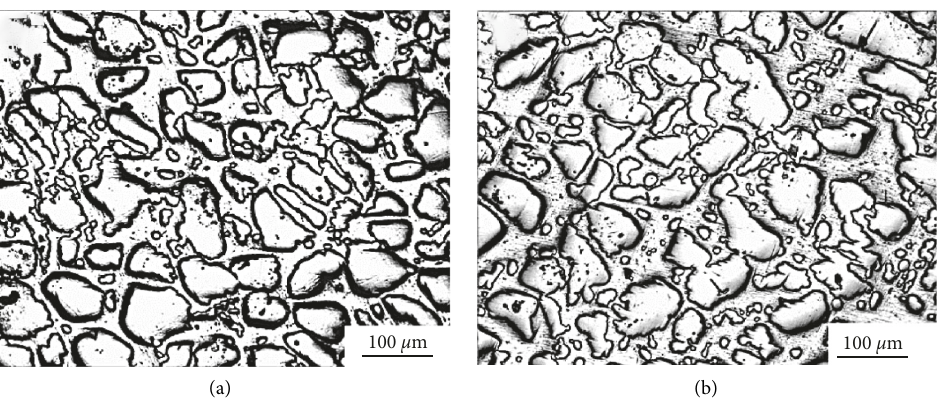
Figure 3: Metallographic photographs of CuCr alloy: (a) before and (b) after 1GPa high-pressure treatment [9].